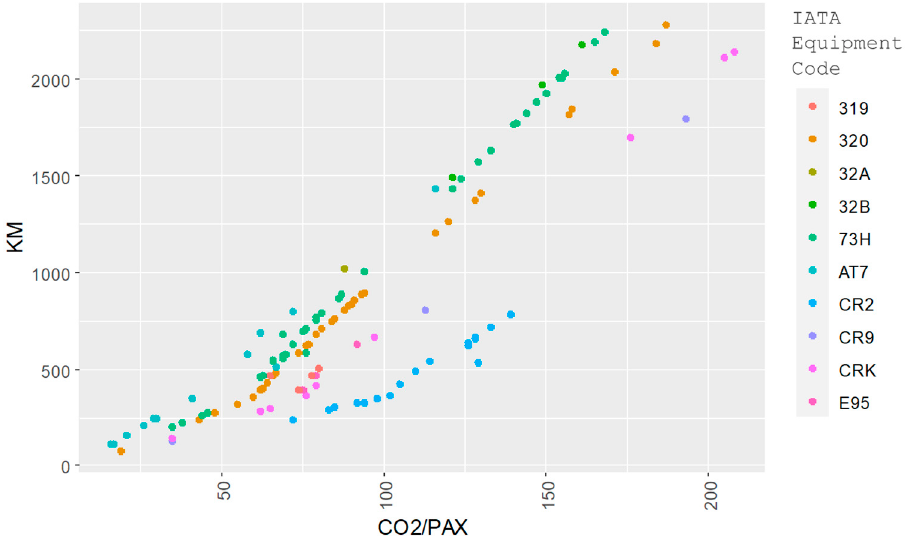
Figure 13. The relative ratio of carbon dioxide emissions in kilograms (kg) per passenger (PAX) according to the distance traveled in kilometers (km) by each aircraft selected. Source: own elaboration based on data compiled from [19] and weighted from [20].